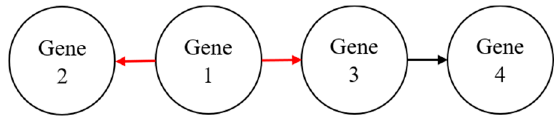
Figure 1. A hypothetical gene network to illustrate the importance of genes in a random walk.